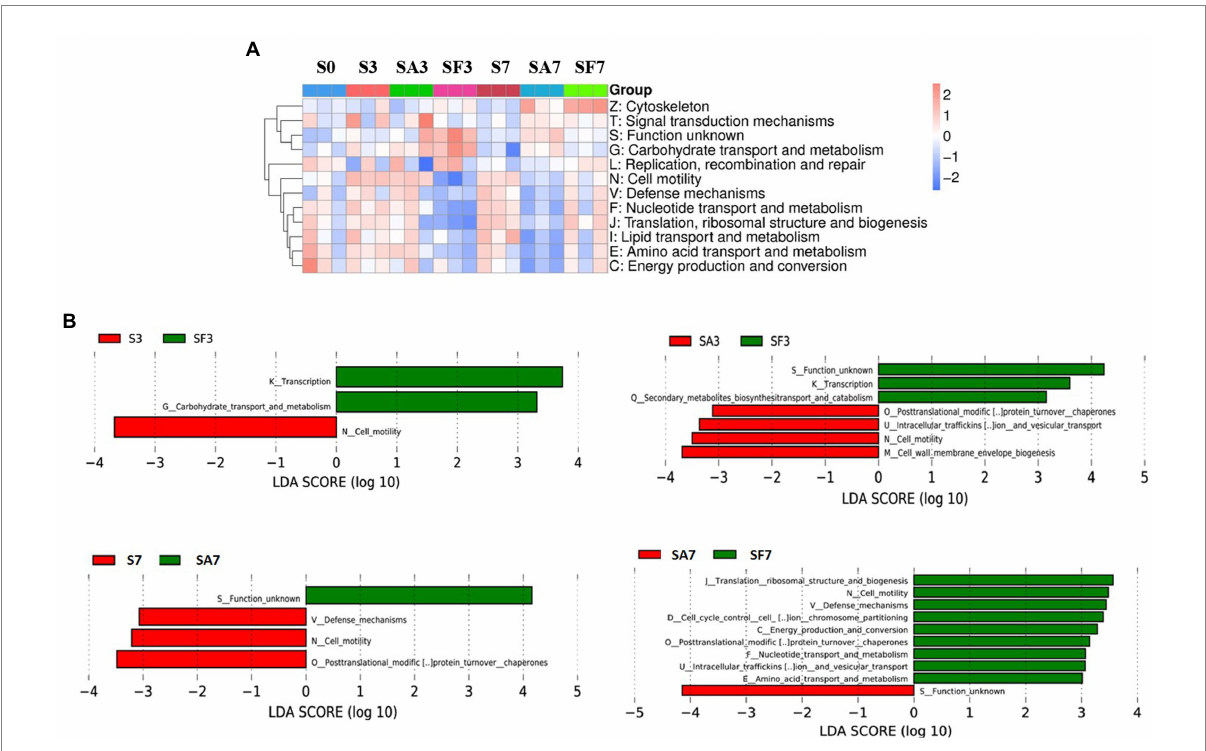
FIGURE 6 Functional diversity of the microbiomes among different soil samples based on eggNOG metabolic pathway analysis (A) Heatmap of enrichment differences in metabolic pathways among the samples. The X -axis represents the sample group name; the Y -axis represents the eggNOG metabolic pathway annotation information. (B) Distribution of LDA scores of functional differences between samples. The X -axis represents the LDA score; the Y -axis represents the eggNOG metabolic pathway annotation information. Three biological replicates per sample were analyzed. Data are expressed as mean ± SE ( n = 3). S0, Mock-inoculation control, before treatment; S3, mock-inoculation control, 3 dpi; S7, mock-inoculation control, 7 dpi; SA3, SA + FON treatment, 3 dpi; SA7, SA + FON treatment, 7dpi; SF3, FON treatment, 3 dpi; SF7, FON treatment, 7 dpi. FON, Fusarium oxysporum f. sp. niveum ; SA, salicylic acid; dpi, days